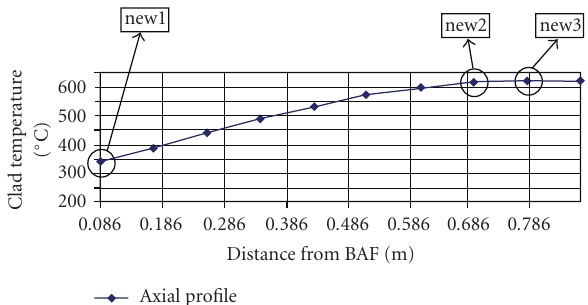
Figure 5: Temperature axial profile (Steady State—Average Chan- nel) with the points selected for the CFD simulations